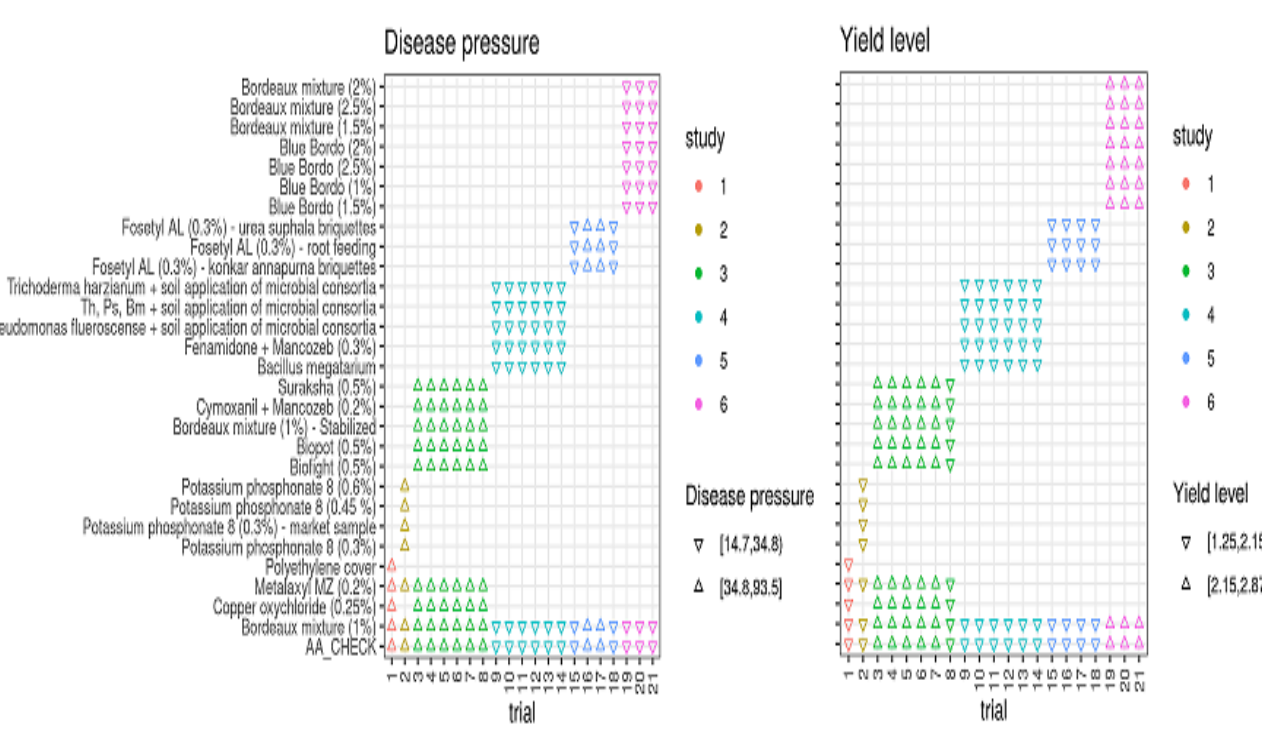
Figure 2. Treatment mean values (points) of FRD incidence and arecanut yield (Kg/Palm). AACHECK = untreated control, with treatments tested at different concentrations. Th =